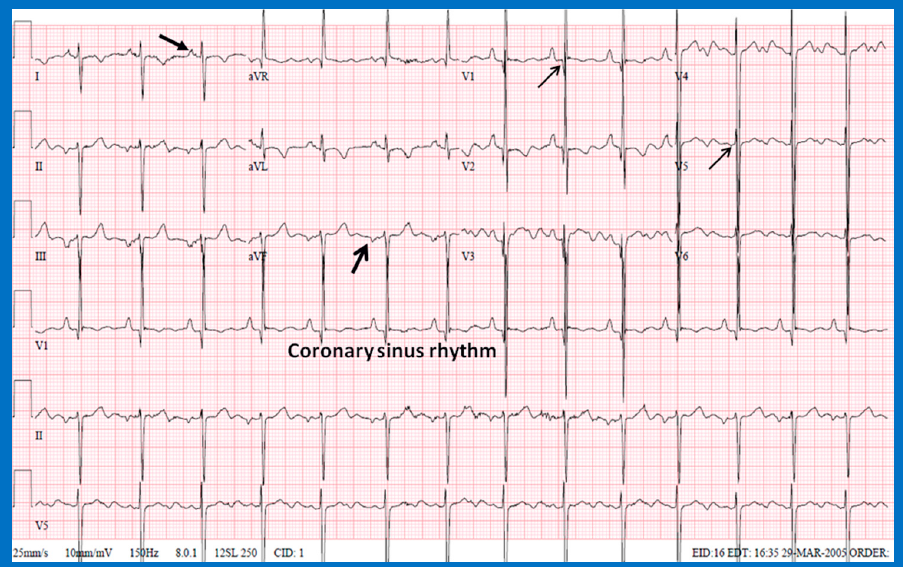
Figure 19. Electrocardiogram (ECG) of a patient illustrating positive P waves in lead I and negative P waves in lead AVF (thick arrows) with a P wave vector of − 45 degrees. Such a pattern is suggestive of a low atrial or coronary sinus rhythm. However, such P wave vectors are not useful in situs localization. The ECG also shows Q waves in the right chest leads (V1 and V2) and no Q waves in the left chest leads (V5 and V6) (thin arrows); such a pattern is indicative that the ventricles are inverted. However, such an abnormality may also be observed in patients with right ventricular hypertrophy of a severe degree. Reproduced from reference [4].